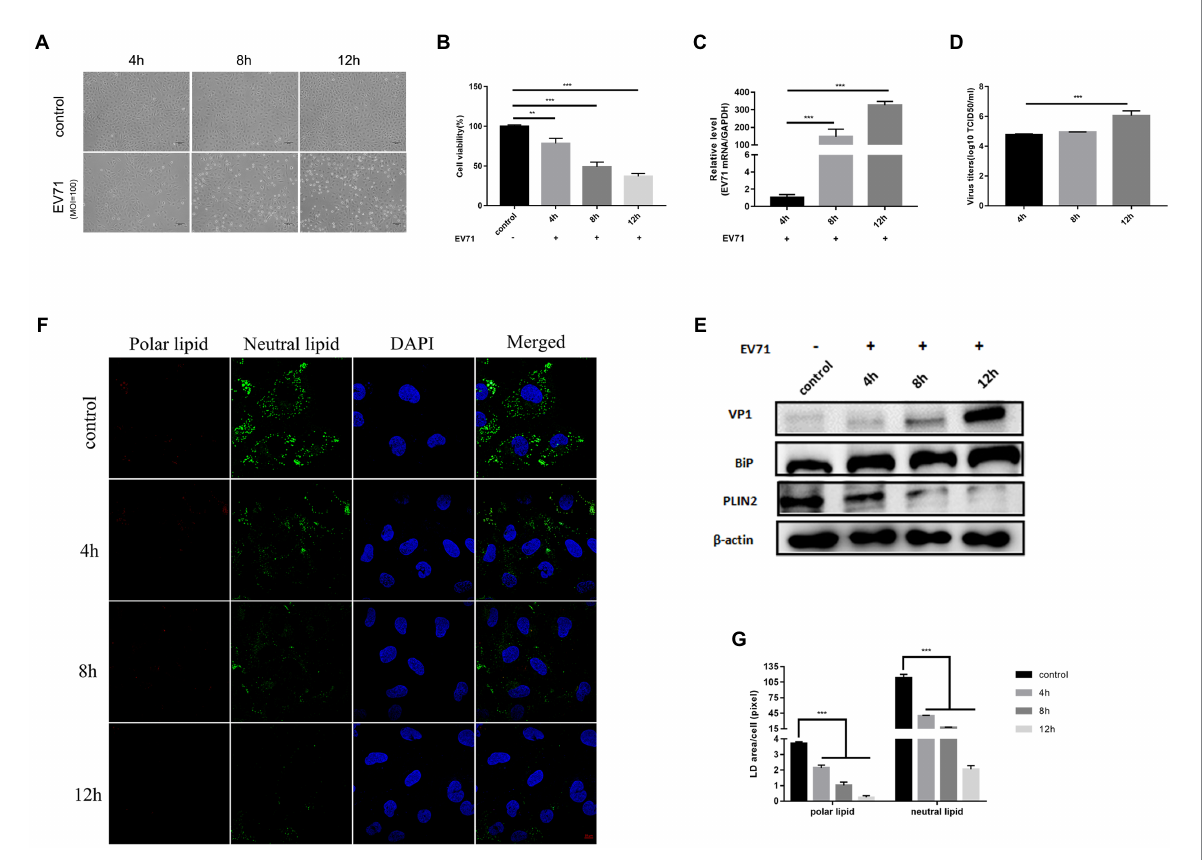
FIGURE 1 EV-A71 infection of HUVECs caused ER stress and altered lipid metabolism. HUVECs were infected with EV-A71 at moi 100. (A) Cytopathic effects were recorded under an inverted light microscope, mock-infected cells were used as negative controls. (scale bar 100 μ m). (B) CCK8 detected cell viability at 4 h, 8 h and 12 h after infection. (C) Intracellular RNA was extracted at 4 h, 8 h and 12 h after infection, the mRNA expression of EV-A71 was calculated with 4 h as control. (D) Collects 4 h, 8 h and 12 h after infection in the cell supernatant, the titer of virus was detected by TCID50. The EV-A71 virus titers were 1.5 × 10 7 TCID50/ml, 2.7 × 10 7 TCID50/ml and 5.2 × 10 7 TCID50/ml at 4 h, 8 h and 12 h after infection, respectively. (E) The expression levels of VP1, BiP and PLIN2 were detected by western blot at 4 h, 8 h and 12 h after infection. (F) Lipid in cells were stained with Nile Red dye at 4 h, 8 h, and 12 h after infection, and the lipid were observed by confocal microscopy. Polar lipid droplets were red and neutral lipid droplets were green. (G) The lipid droplet area of each cell was quantitatively calculated. All the experiments were carried out in triplicate. Error bars represent SEM. * means p < 0.05, ** means p < 0.01, *** means p <